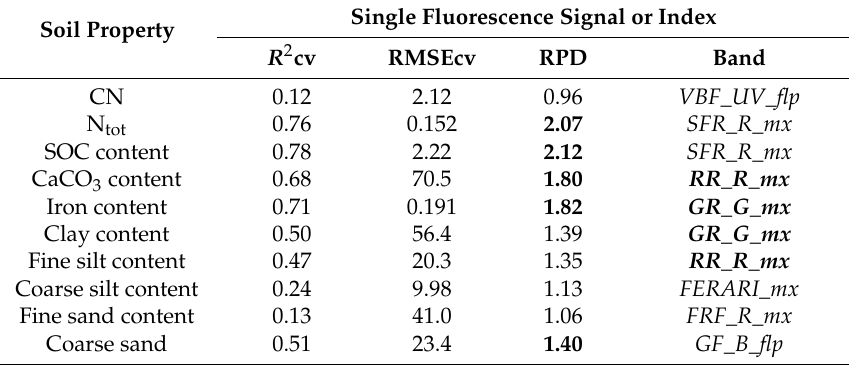
Table 10. Cross-validation performance statistics of simple linear regression from the best Multiplex signals for the topsoil